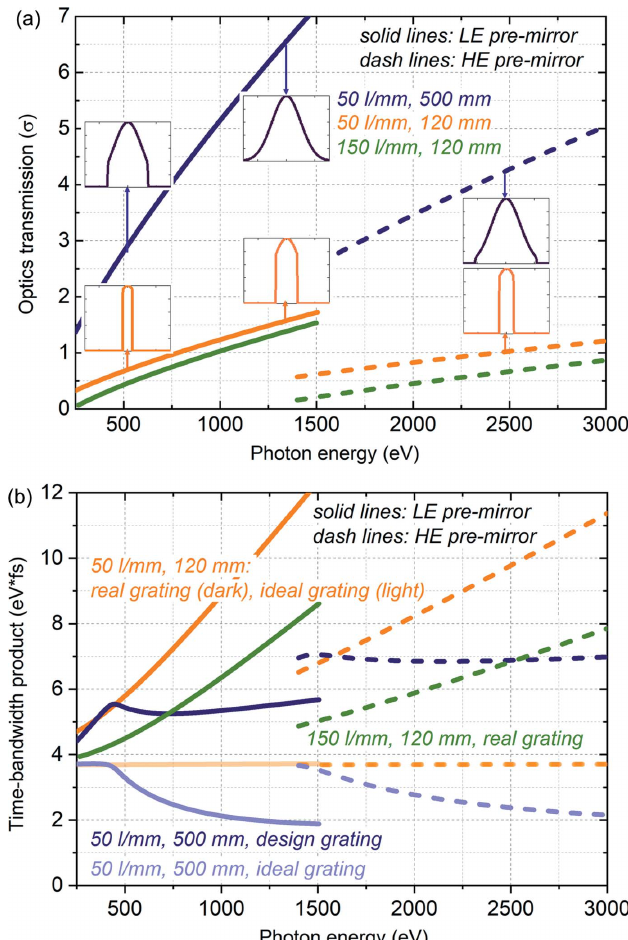
Figure 4 Time–bandwidth product. ( a ) Analytically estimated optics transmission in sigma of Gaussian-like beam cross-section; the inserts show the shape of the beam transmitted by the monochromator. ( b ) Analytically estimated time–bandwidth product in the case of ideal optics with a perfect slope and a perfect VLS law, as well as in the case of the designed grating and installed gratings. Operation in first diffraction